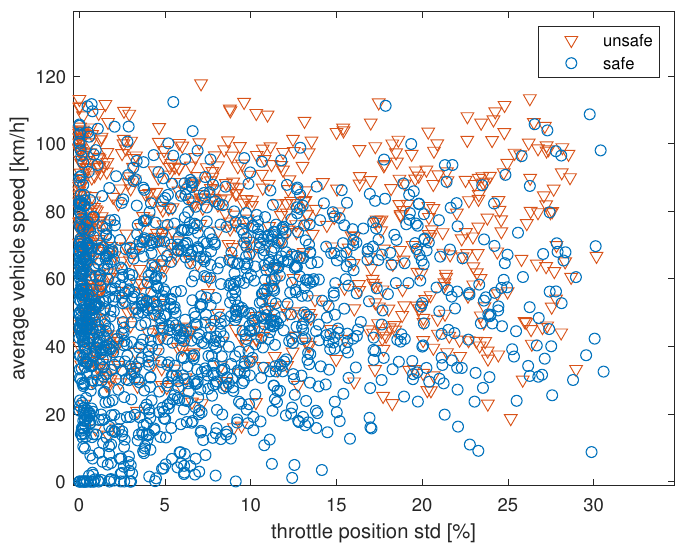
Figure 4. Scatter plot of the standard deviation of the throttle position versus the average vehicle